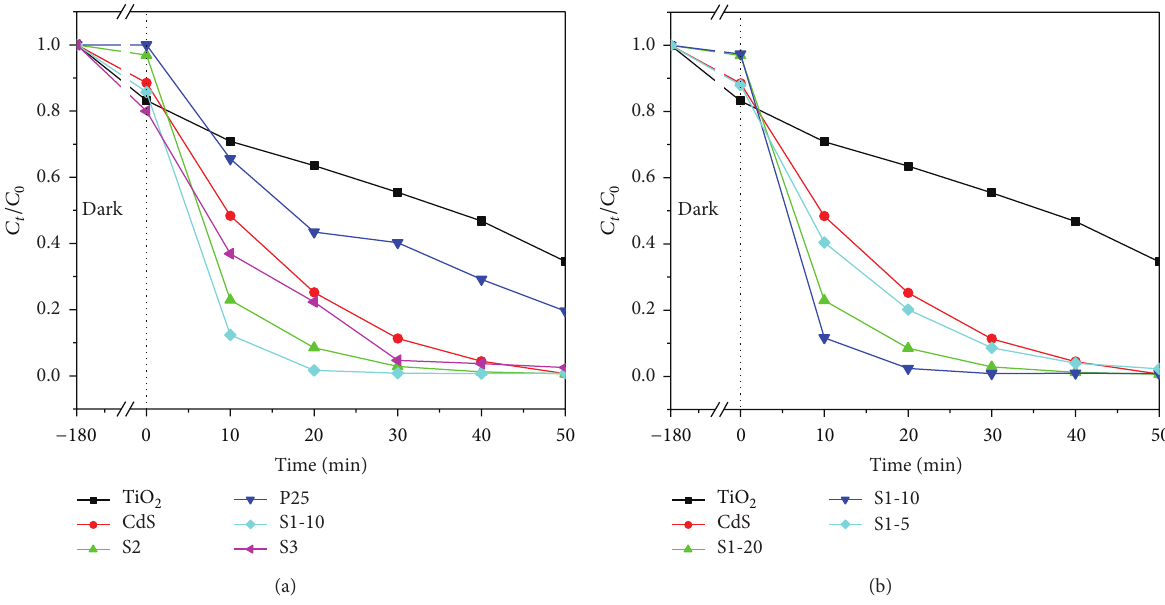
Figure 1: 𝐶 𝑡 /𝐶 0 versus time curves of RhB photodegradation under visible light ( 𝜆 > 420 nm) irradiation. (a) S1-10: 10wt% TiO 2 /CdS (10h), S2: 12wt% TiO 2 /CdS (10h), and S3: 10wt% TiO 2 /CdS (10h); (b) S1: 10wt% TiO 2 /CdS (10h), S1-5: 10wt% TiO 2 /CdS (5h), and S1-20: 10 wt% TiO 2 /CdS (20 h).